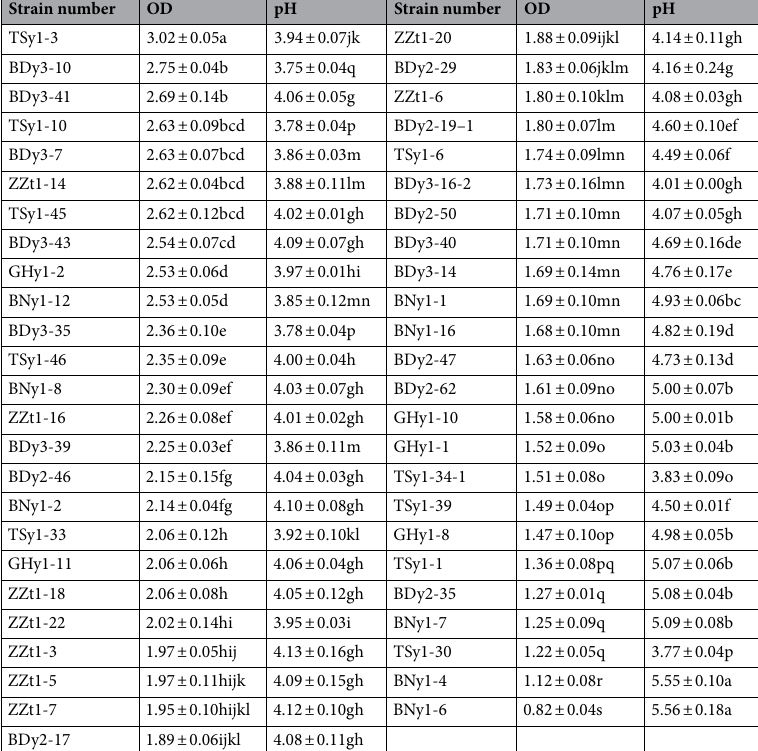
Table 3. OD and pH values of lactic acid bacteria cultured in MRS medium for 24 h. Values with different lowercase letters show significant ( P <